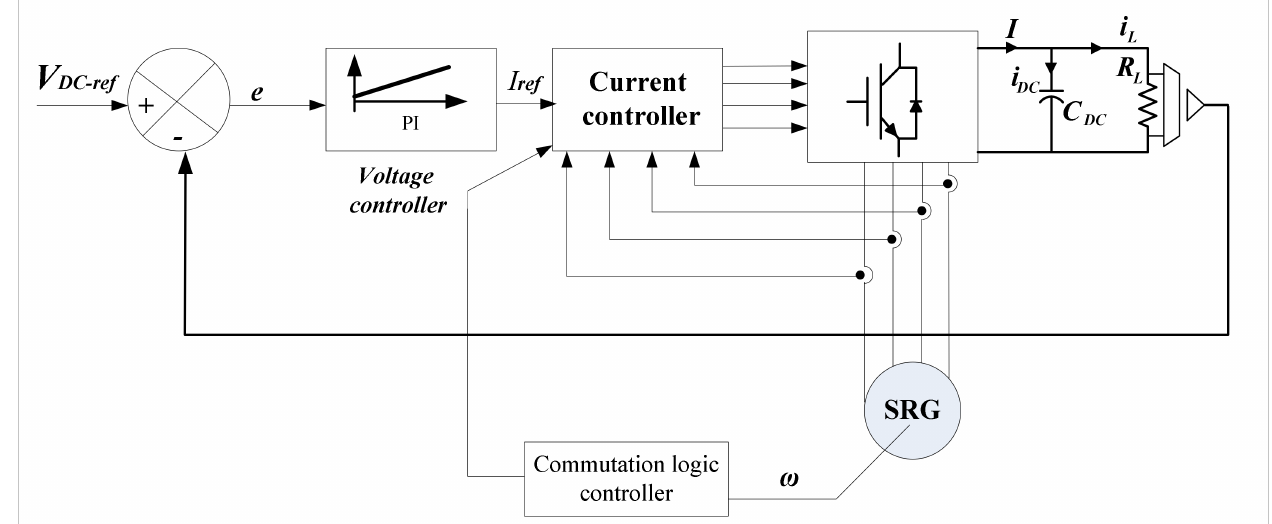
Figure 6. SRG voltage control scheme.